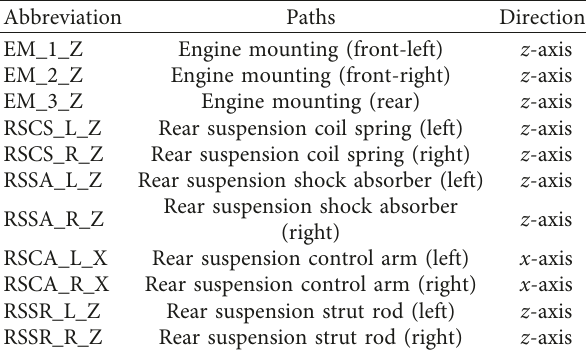
Table 2: Transfer paths description.